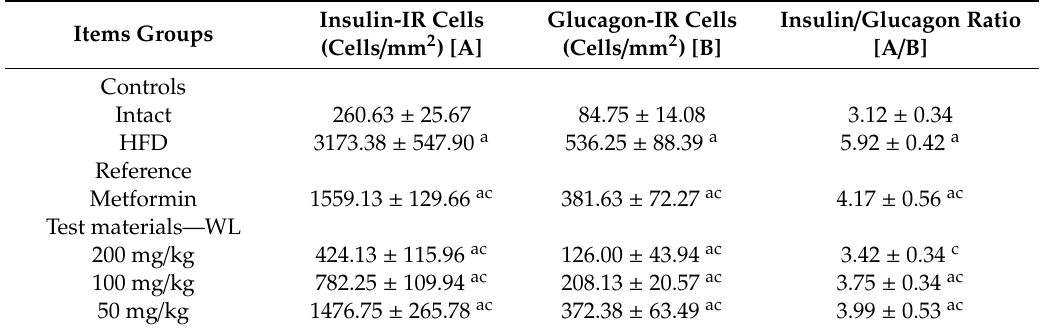
Table 8. Changes in histopathology-histomorphometry of the pancreas in NFD or HFD supplied mice.